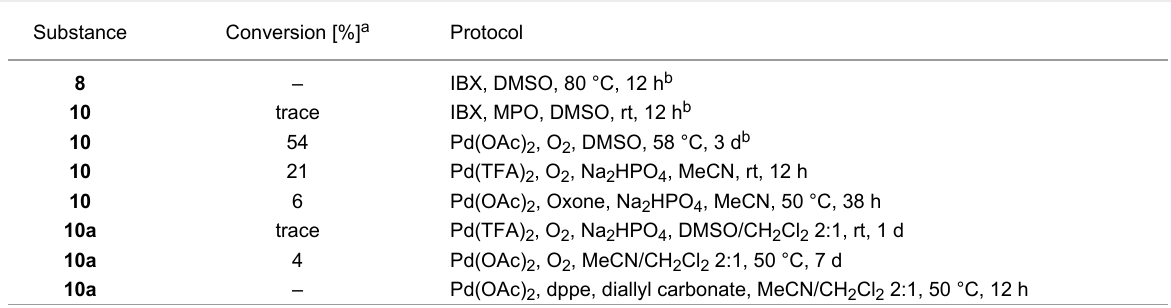
Table 2: Investigated methodologies for preparation of 1